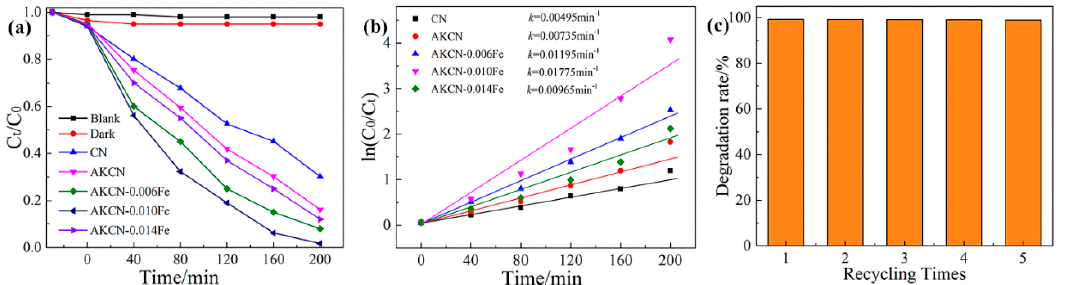
Figure 7. ( a ) Degradation efficiencies of the as-prepared semiconductor photocatalysts toward Rhodamine B (RhB) ( b ) dynamics of degradation reactions, and ( c ) recycling experiments of RhB photocatalytic degradation.